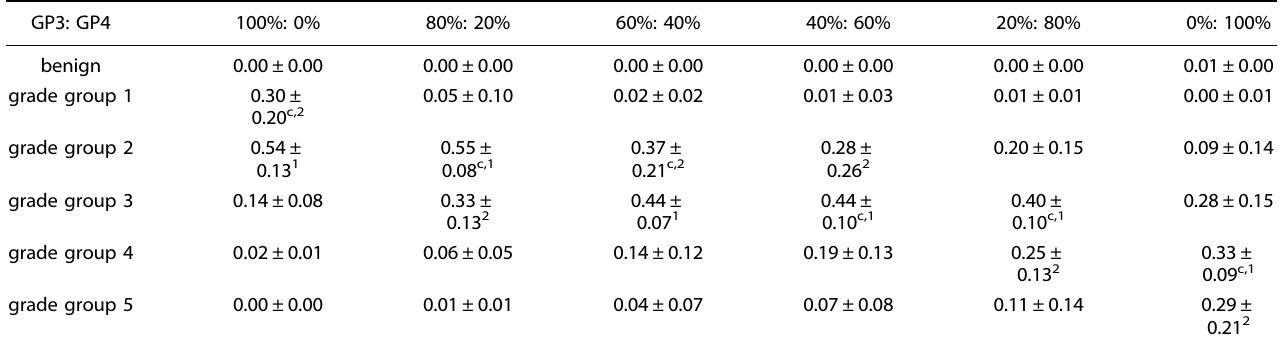
Table 3. Mean and deviation values of the actual output of the second stage model for a set of combination ratios between Gleason patterns 3 and